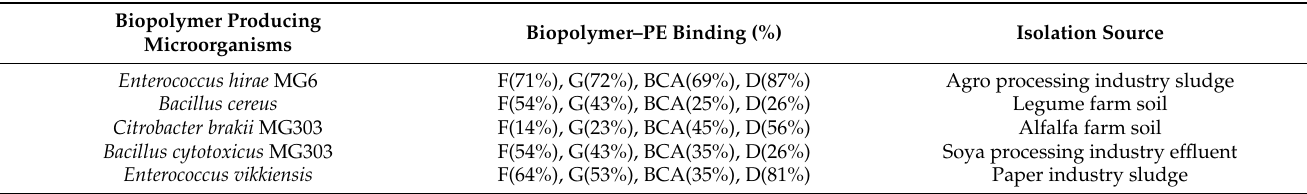
Table 1. Bacterial sources of biopolymers and their phytoestrogen (PE)-binding ability. The PEs used were formononetin; BCA: biochanin A; G: genistein; and D: daidzein. The initial screening was performed with 1 mg of purified extracellular polymers from each isolate; the concentration of PEs was 100 µ g/mL.